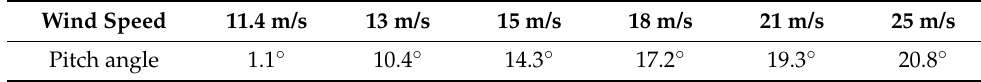
Table 4. Blade pitch angle value according to the wind speed.